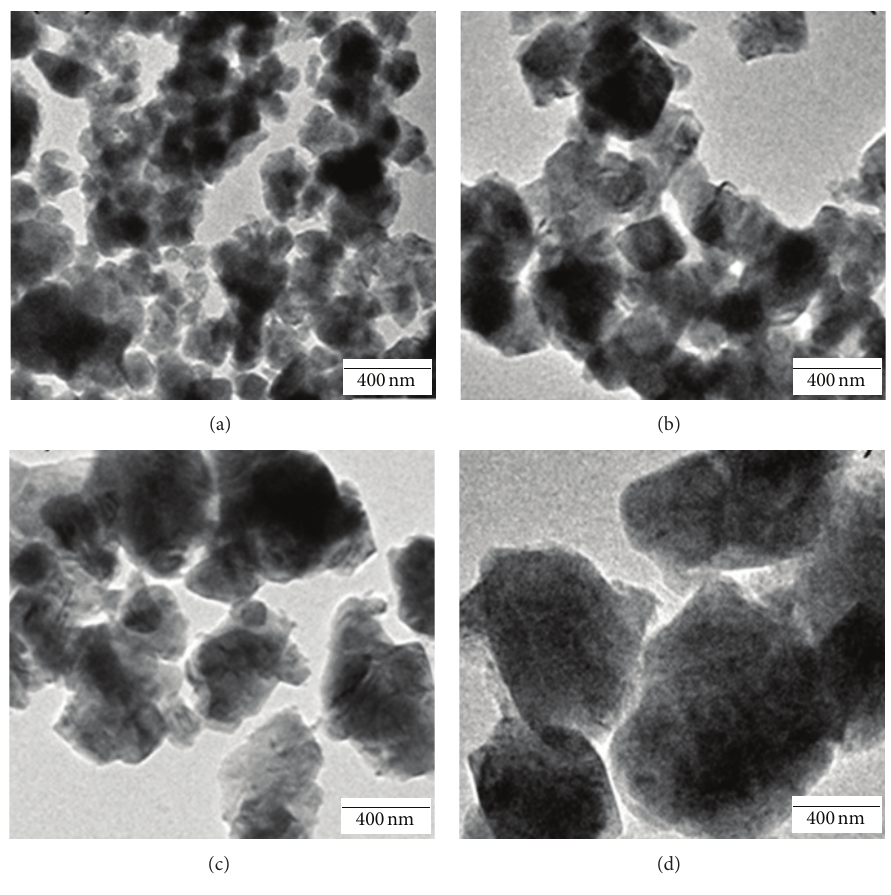
Figure 1: TEM images of the 3Y-TZP